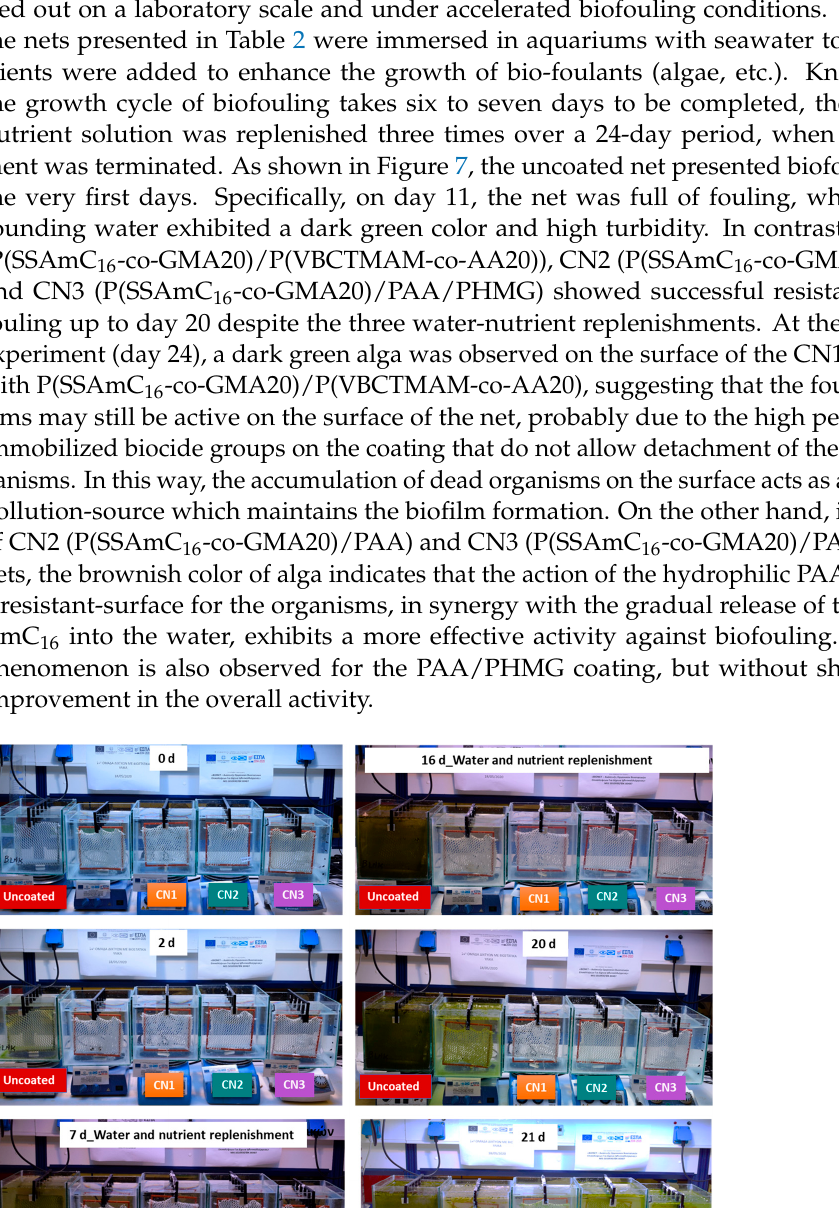
Figure 8. Photographs of the uncoated and coated nets before and after pressure washing with wa ‐ ter, on day 24 of the experiment. A crucial question for the potential application is whether the nets can be repeatedly coated after use. To check this point, the net CN1, after application under accelerated la ‐ boratory conditions and washing with high pressure water, was re ‐ coated using the same